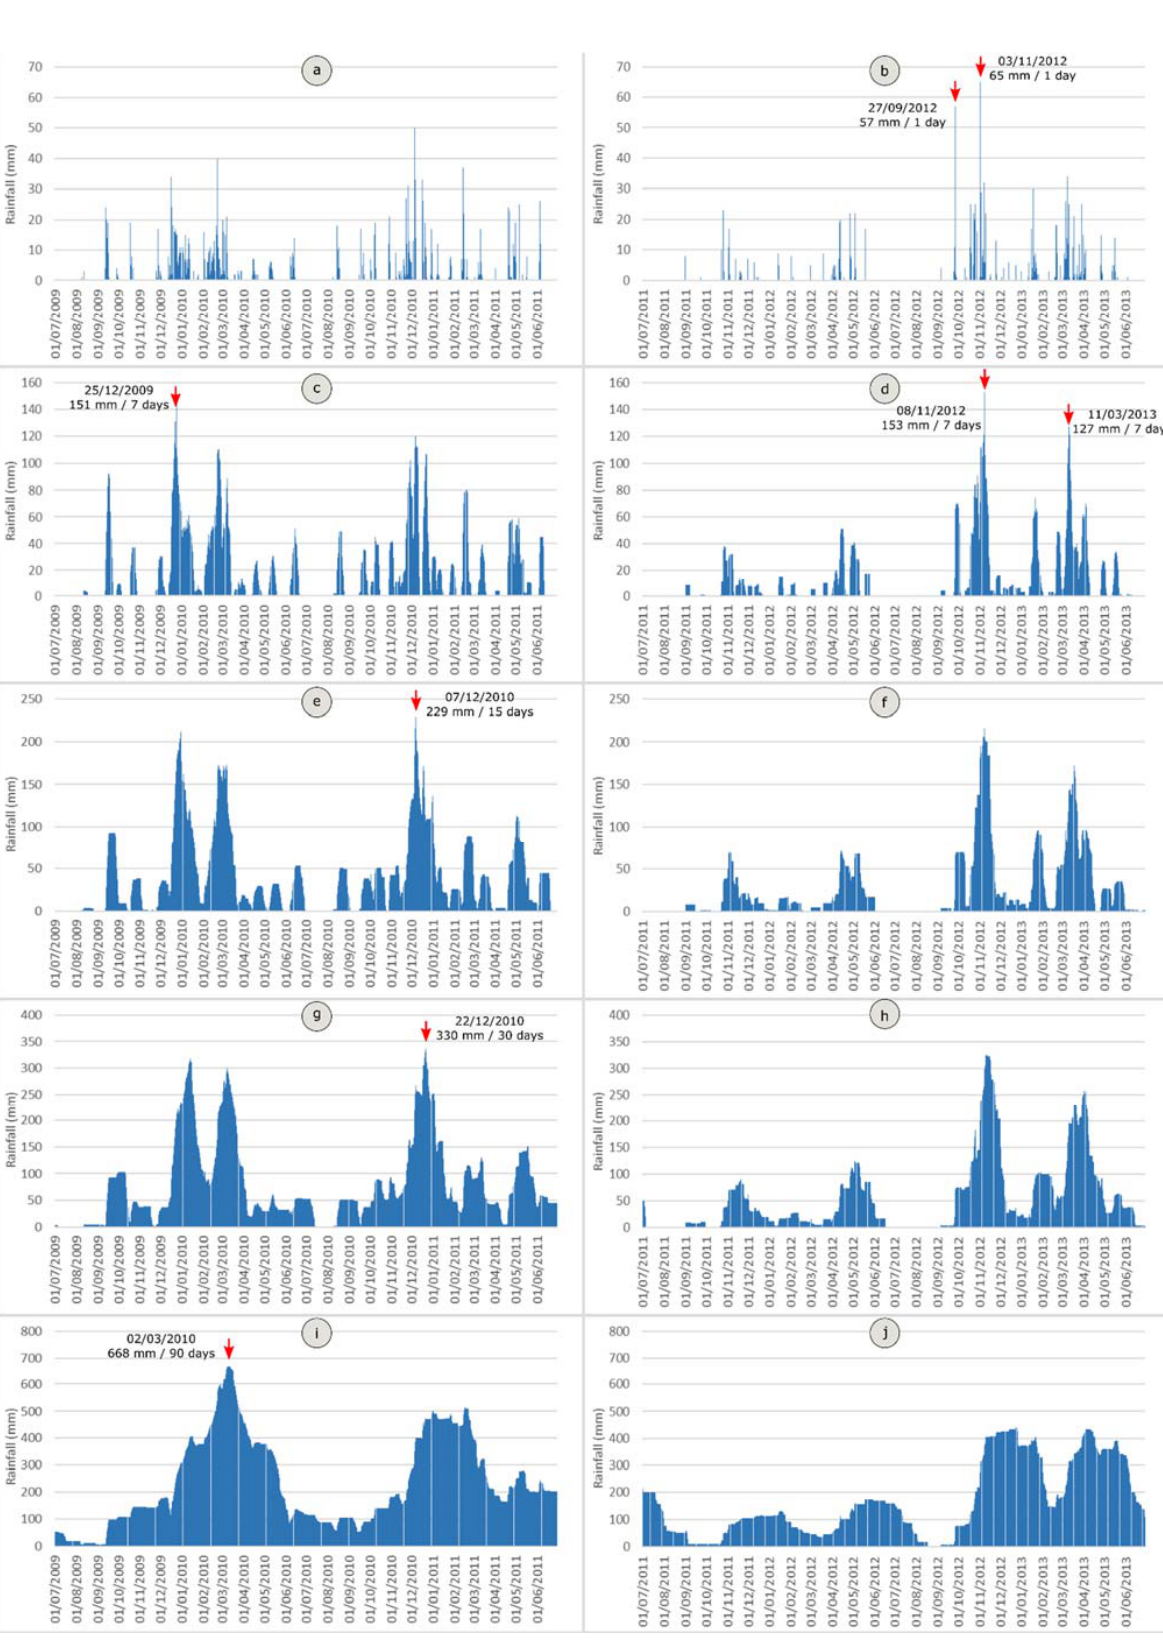
Figure 5. Rainfalls series (two-year) for the incidence points 099 and 174: ( a , b ), Daily rainfall; ( c , d ), 7-day antecedent rainfall; ( e , f ), 15-day antecedent rainfall; ( g , h ), 30-day antecedent rainfall; and ( i , j ), 90-day antecedent rainfall. Red arrows represent the days (E–D pairs) selected as rainfall events for each point.